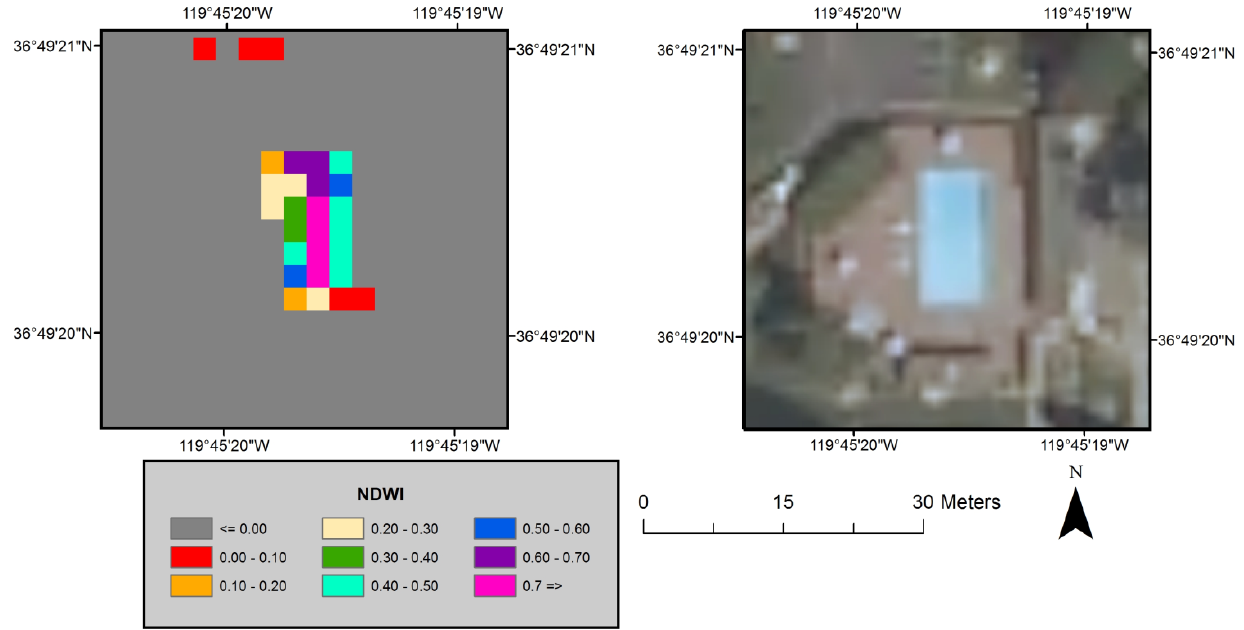
Figure 3. Color-coded NDWI image of an apartment complex swimming pool ( left ). True color NAIP image of same location acquired on 27 June 2009 ( right ).